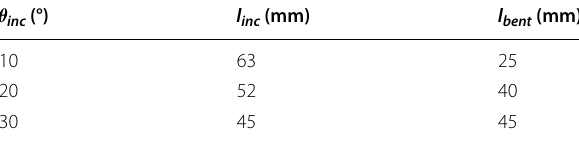
Table 5 Experimental results for allowable